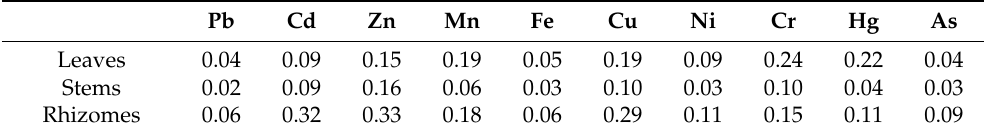
Table 6. Bioaccumulation factor (BAF) values for heavy metal content in greater celandine tissues.